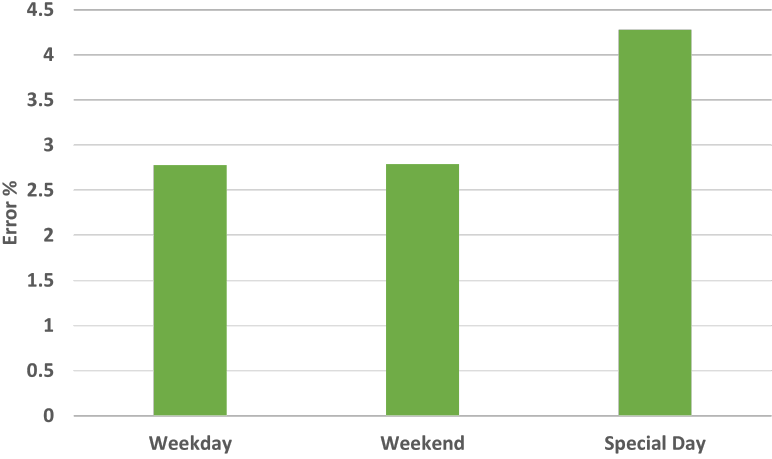
Figure 5. Mean error by weekday, weekend, and special